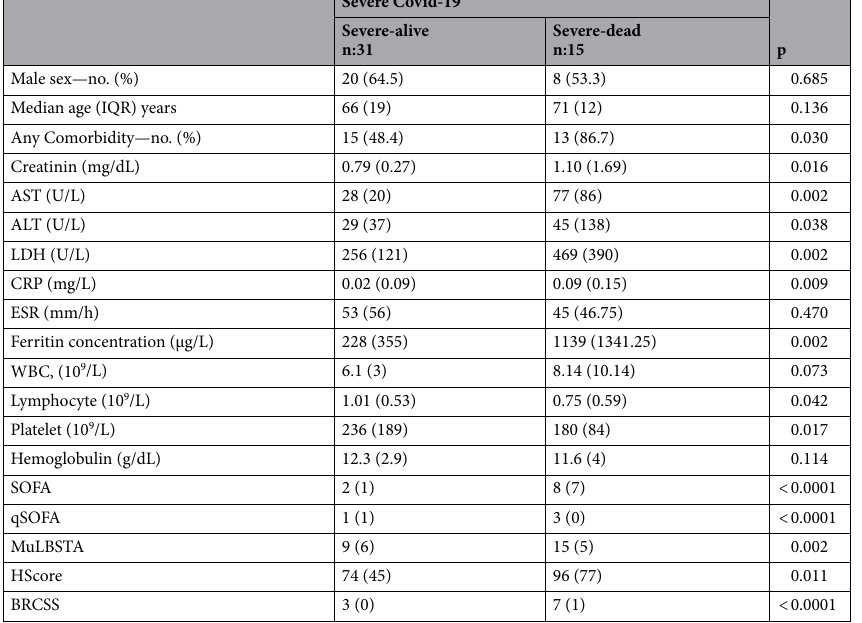
Table 2. Evaluation of the clinical status, demographics, past-history, laboratory parameters and scores between alive and dead severe patients at the time of admission. All laboratory parameters have been calculated as median (IQR). ESR Erythrocyte sedimentation rate, CRP C-reactive protein, ICU Intensive care unit, CHD Coronary heart disease, WBC White blood cell count, AST Serum aspartate aminotransferase, ALT Serum alanine aminotransferase, LDH ; Lactate dehydrogenase, SOFA sequential organ failure assessment score, qSOFA quick sequential organ failure assessment score, MuLBSTA multilobularinfiltration, hypo-lymphocytosis, bacterial coinfection, smoking history, hyper-tension and age score, HSCORE hemophagocytosis score, BRCSS Brescia respiratory covid severity